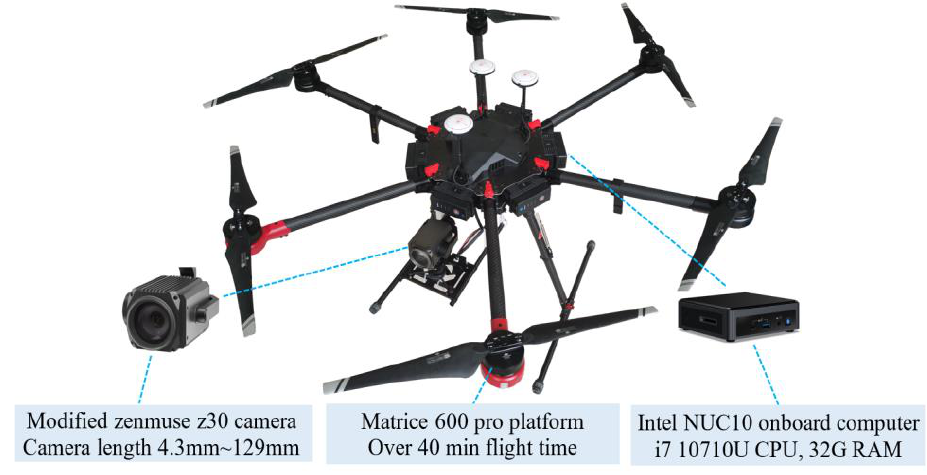
Figure 2. Design of the UAS.